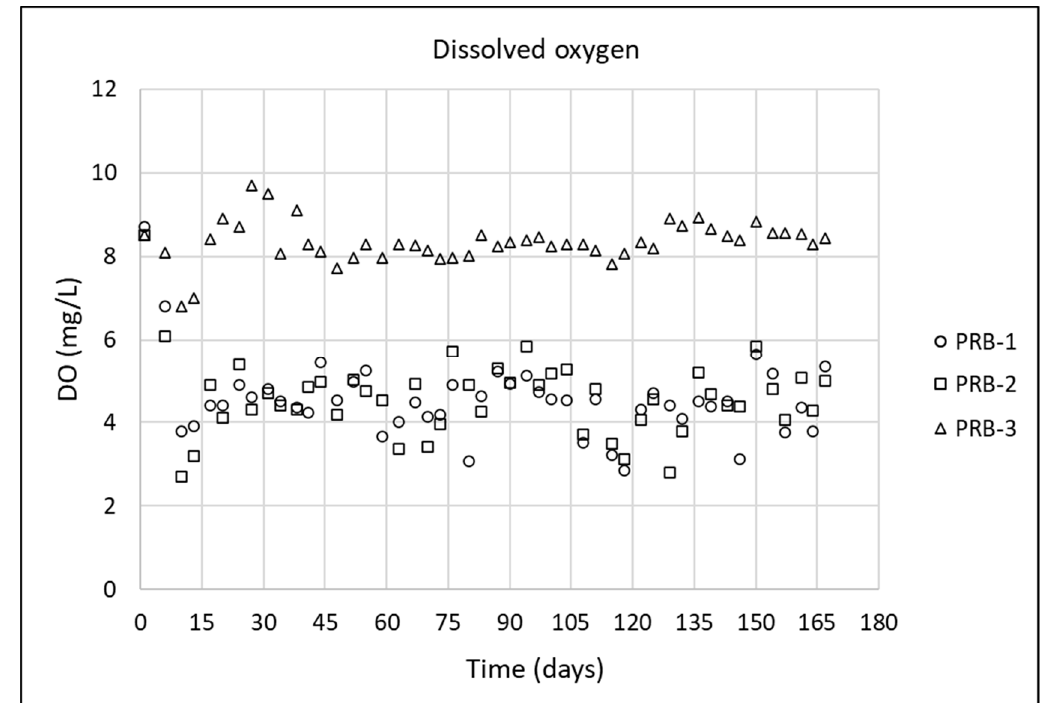
Figure 8. Changes in dissolved oxygen in PRB column reactors.